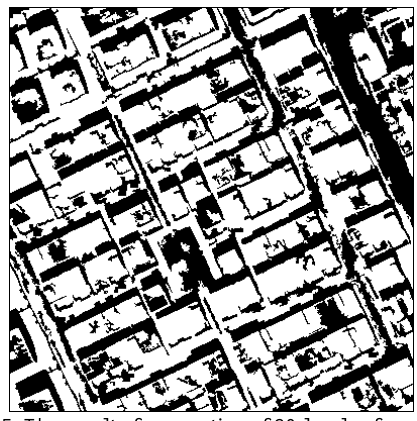
Figure 5. The result of summation of 20 levels of performing opening